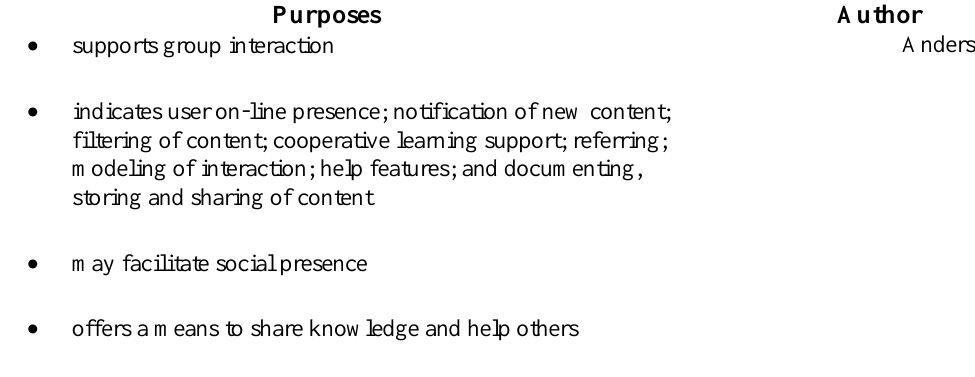
Table 1. Summary of Purposes of Social Software and Blogging